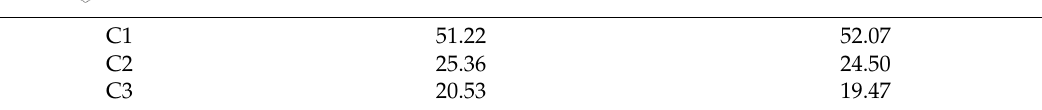
Experimental Chemical Shifts